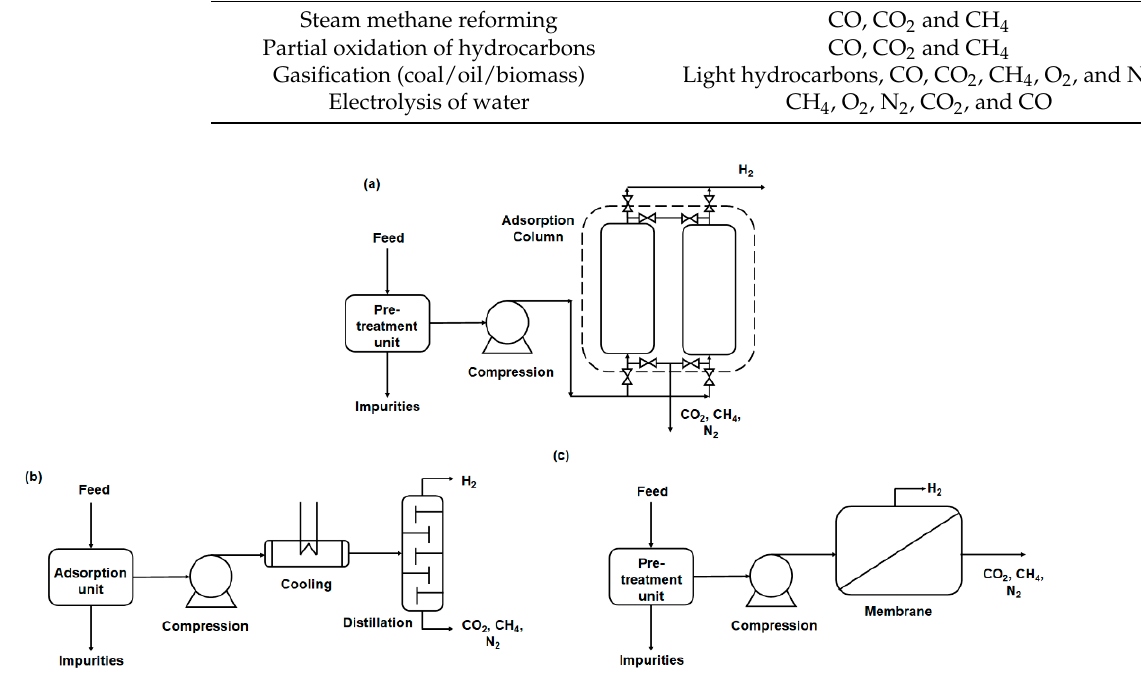
Figure 2. Illustration of ( a ) pressure swing adsorption (PSA), ( b ) cryogenic distillation, and ( c ) membrane-based separation. Reprinted with permission from ref. [34]. Copyright 2020 Elsevier.